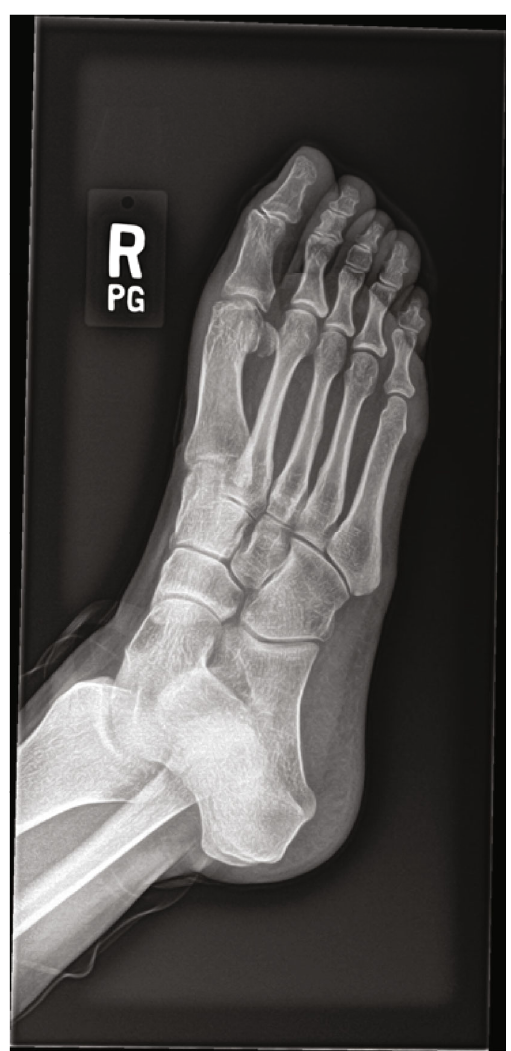
Figure 10: Oblique radiograph of the right foot taken three years post-OCA implantation with complete resolution of hallux